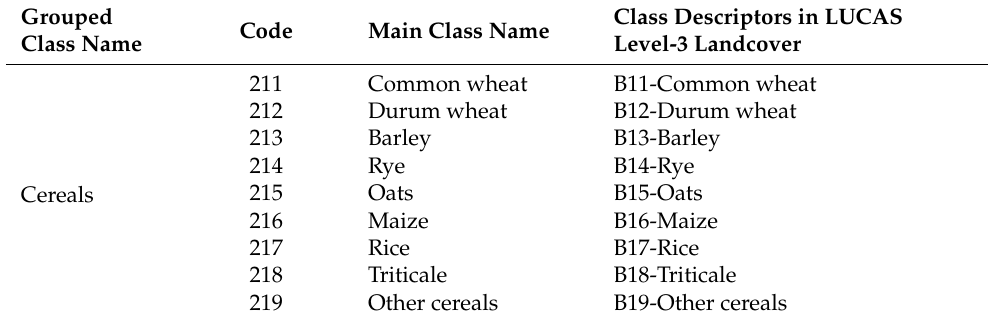
Table 1. The classification scheme adapted from [22] with 19 crop types plus 2 broad categories with Woodland and Shrubland and Grassland classes. The “Main Class Name”, with the respective class codes (“Code”), was used in this